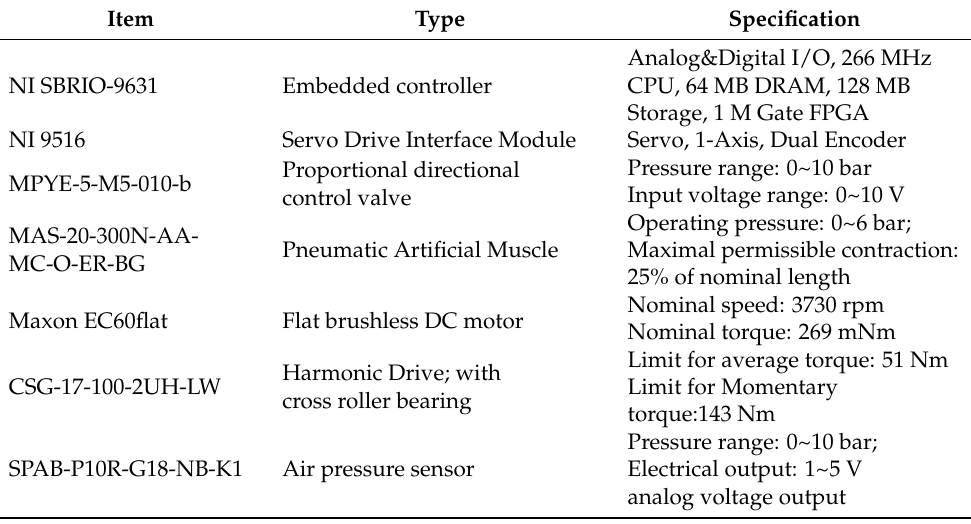
Table 1. Specification list of hardware and equipment for the proposed LLRES.